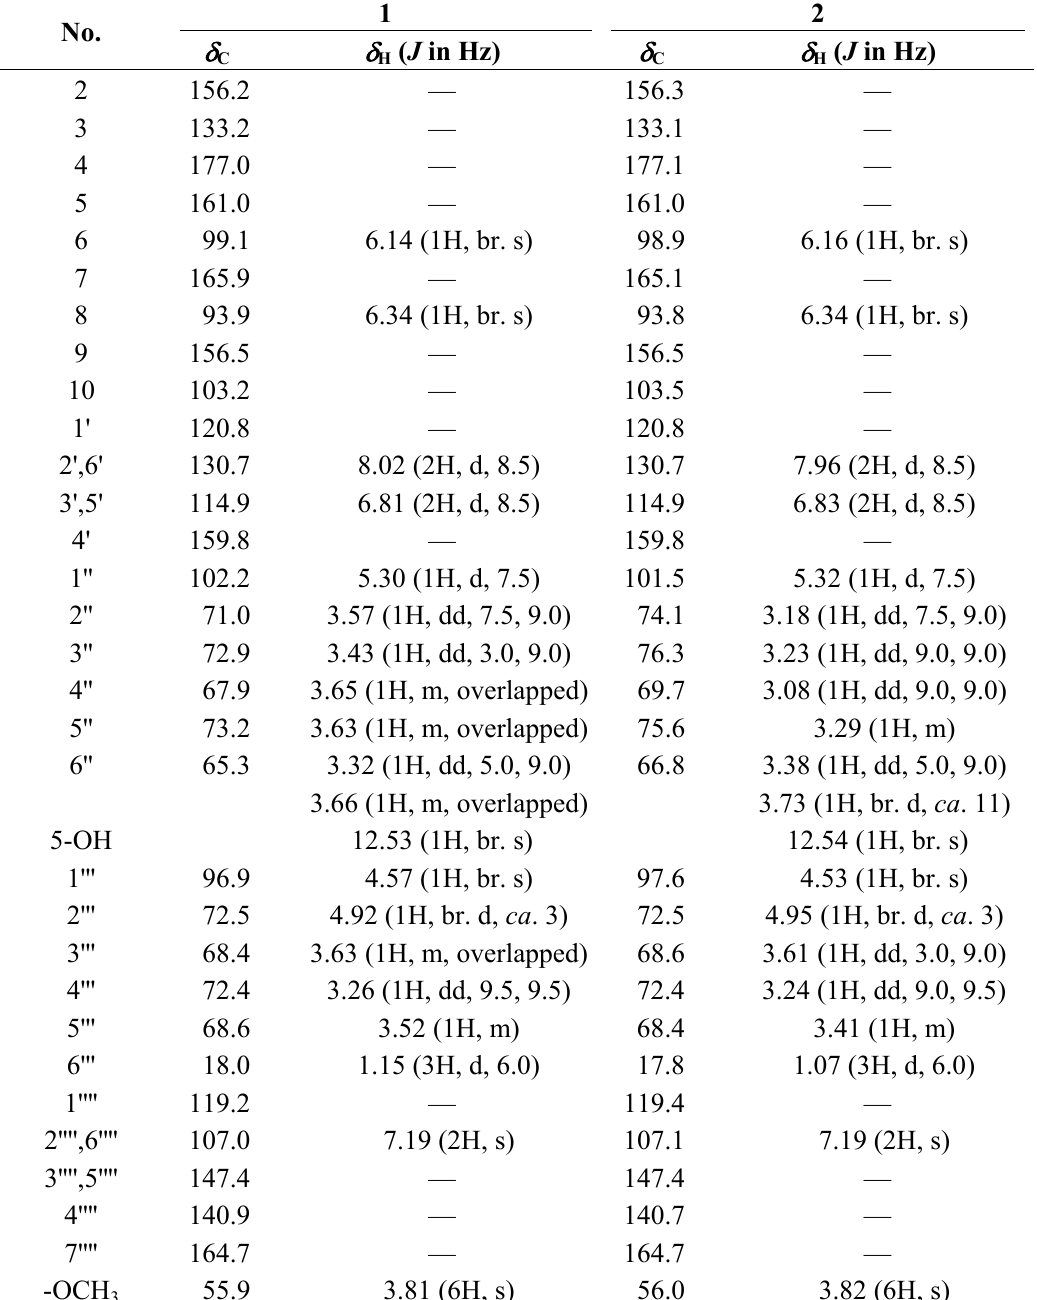
Table 1. 1 H and 13 C-NMR data for compounds 1 and 2 in DMSO- d 125 MHz for 13